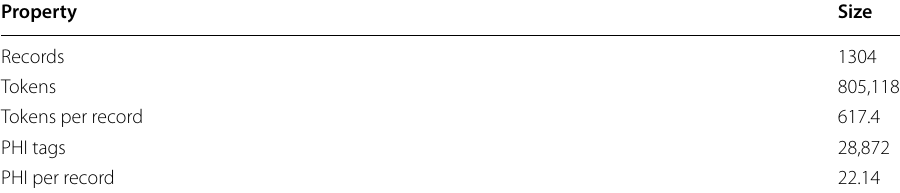
Table 3 2014 i2b2 Dataset [34]